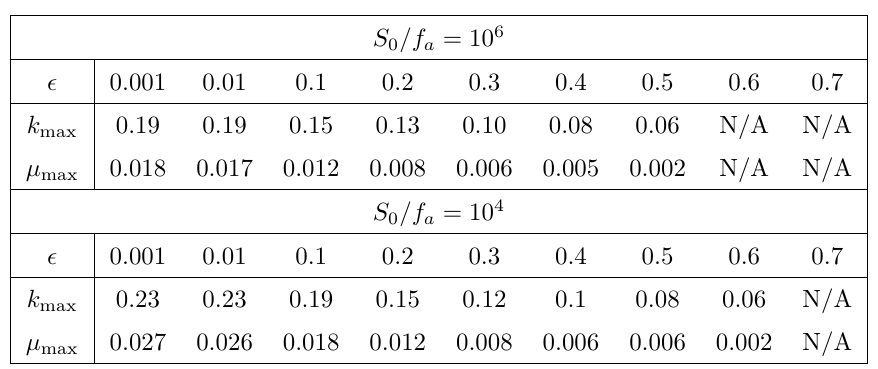
Table 3 . The wavenumber k max having the maximal growth rate µ max , for the theory of eq. (4.1) with a logarithmically evolving soft mass.